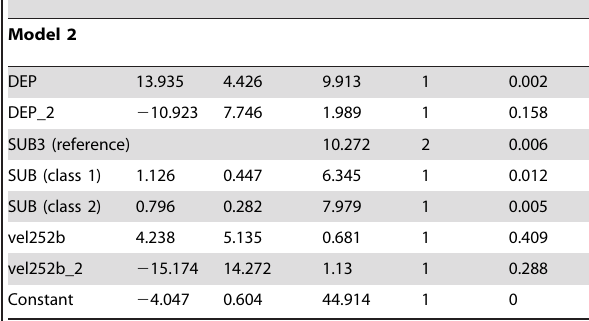
Figure 3. Box-and-whisker plots and bar graphs display the range of environmental values found at 450 sample locations